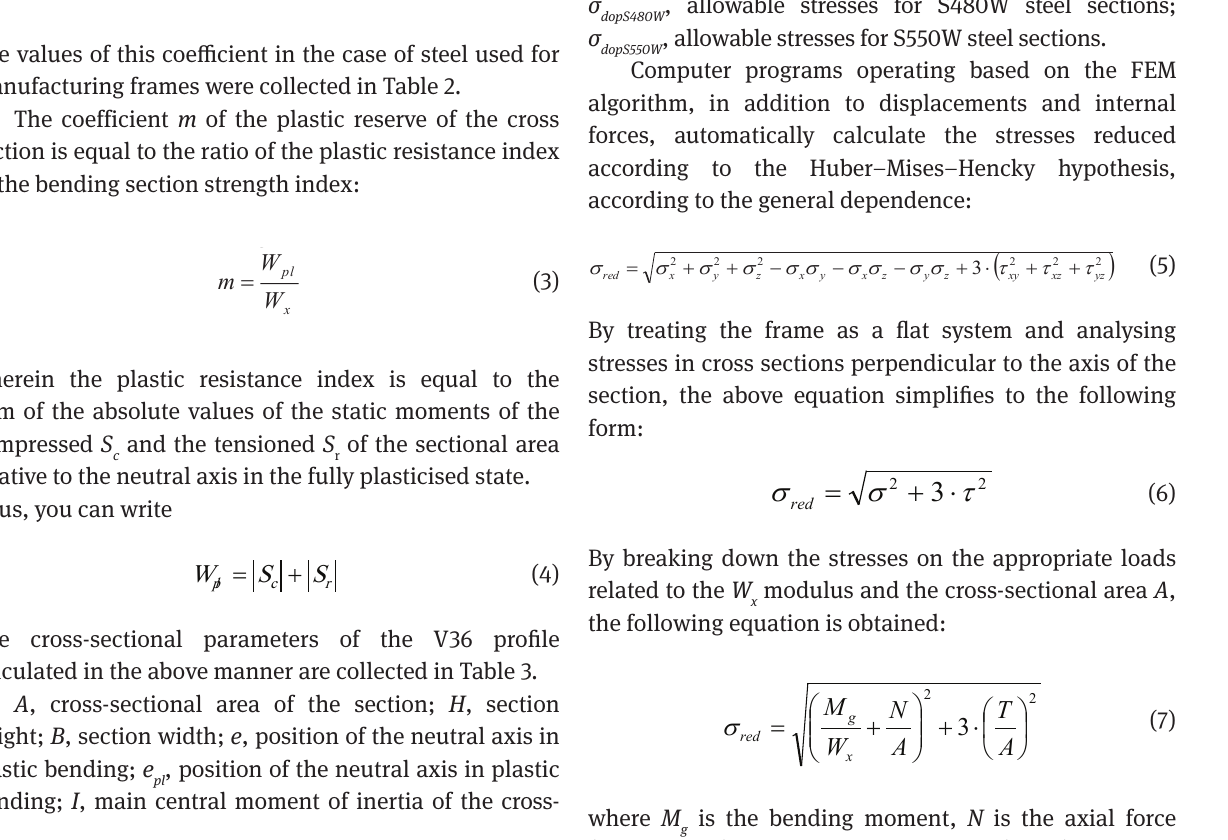
Table 3. Cross-sectional mechanical parameters of V36 profile